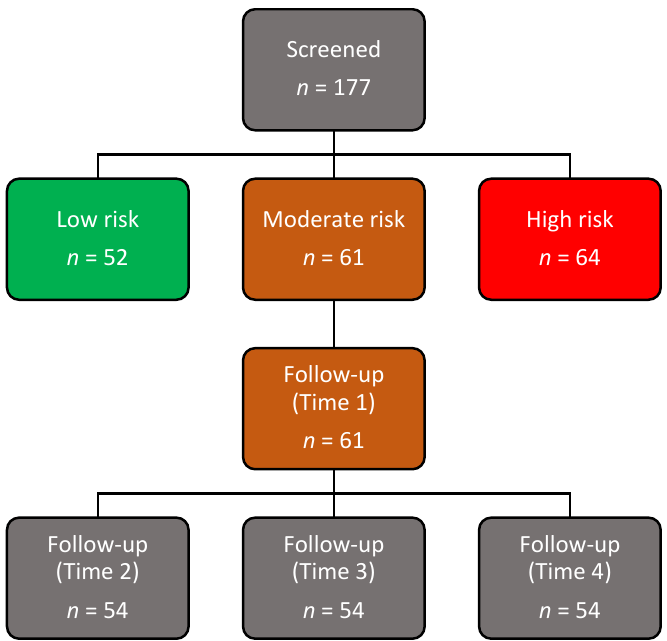
Figure 1. Schematic flowchart of the community cohort study.